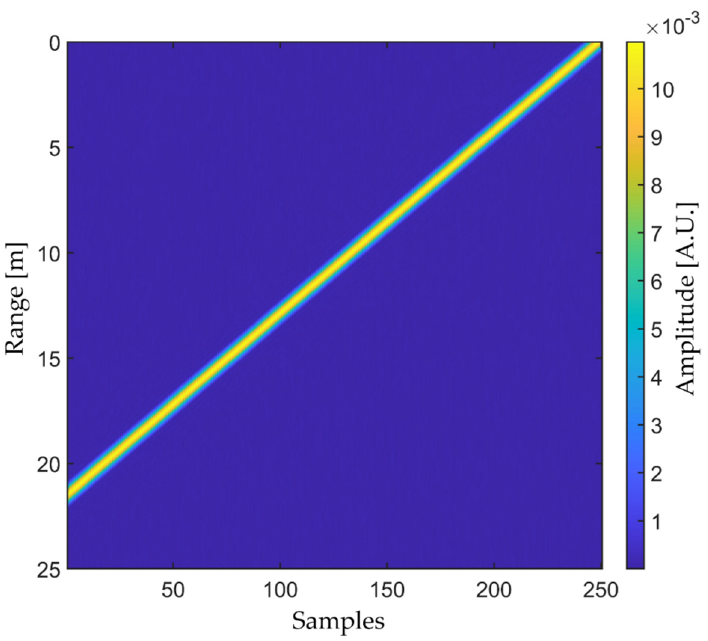
Figure 4. Radar image of GPR with speed of 1.6 m/s .